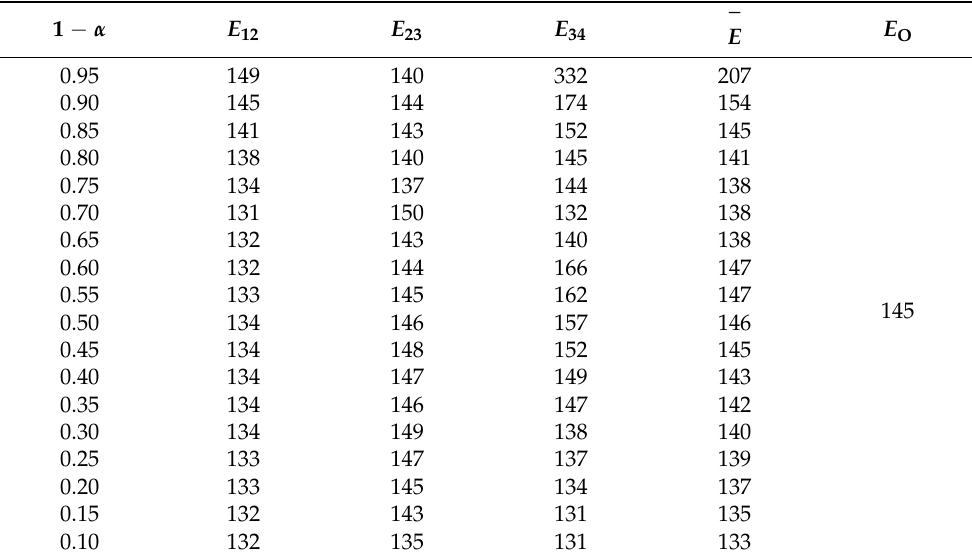
Table 5. The activation energy E O of CYA decomposition (Unit: